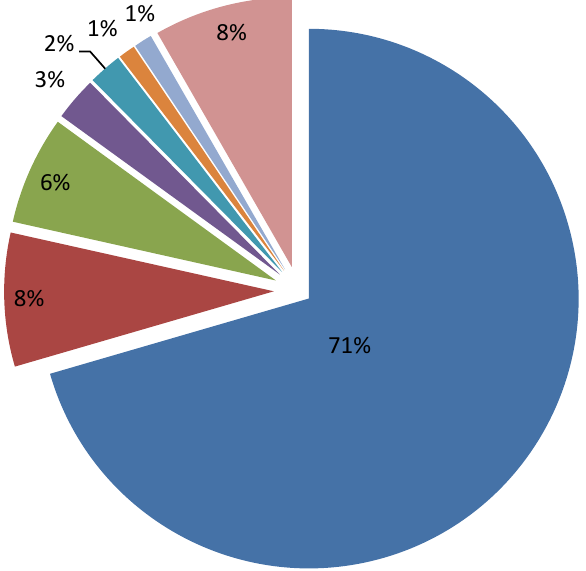
Figure 1. Municipal solid waste component of waste disposed in Sanandaj landfill site in